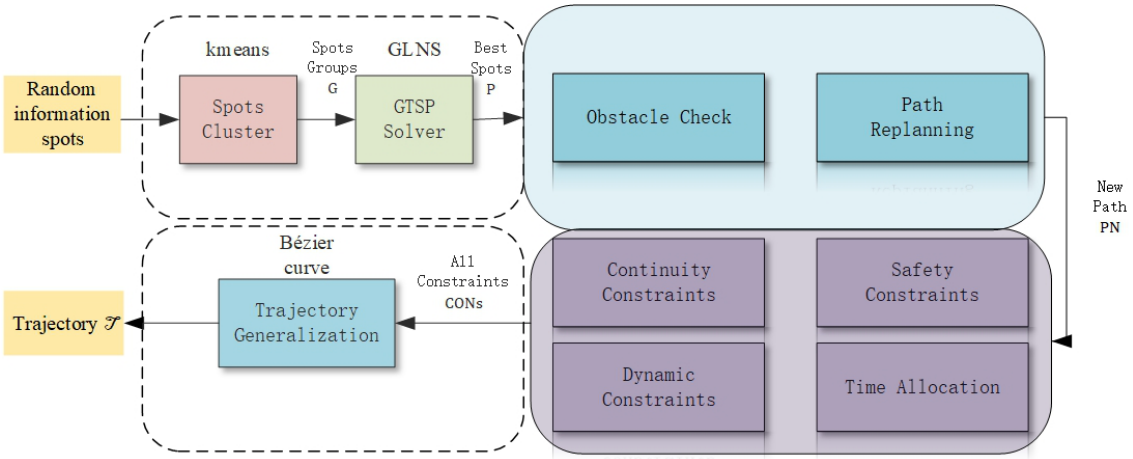
Figure 6. The framework of the whole algorithm. The inputs of this system are randomly created information spots, obstacle sets, and current fields. The output is a smooth, safe, low-cost trajectory conforming to all